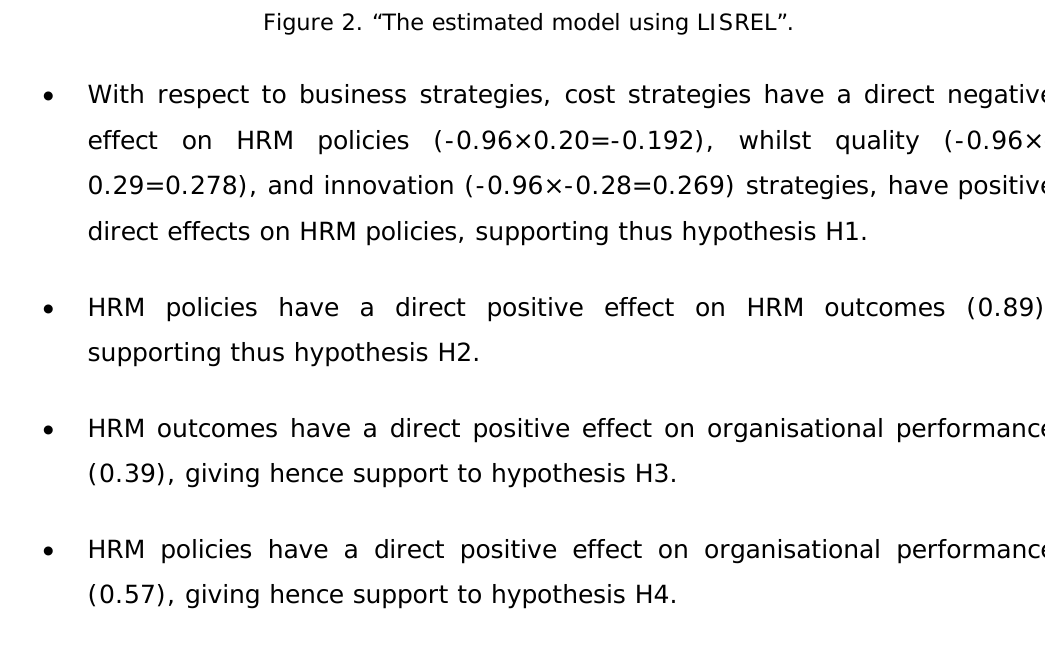
Figure 2. “The estimated model using